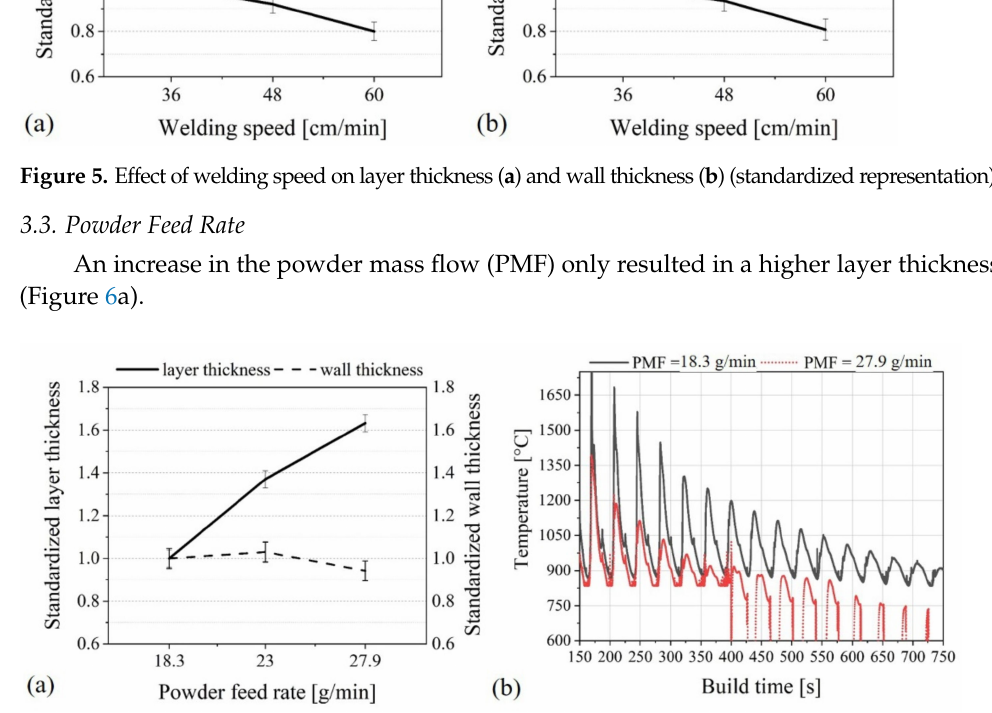
Figure 6. Standardized representation of the effect of welding speed on layer and wall thickness ( a ). Evolution of the part temperature as a function of the build time and the PMF ( b